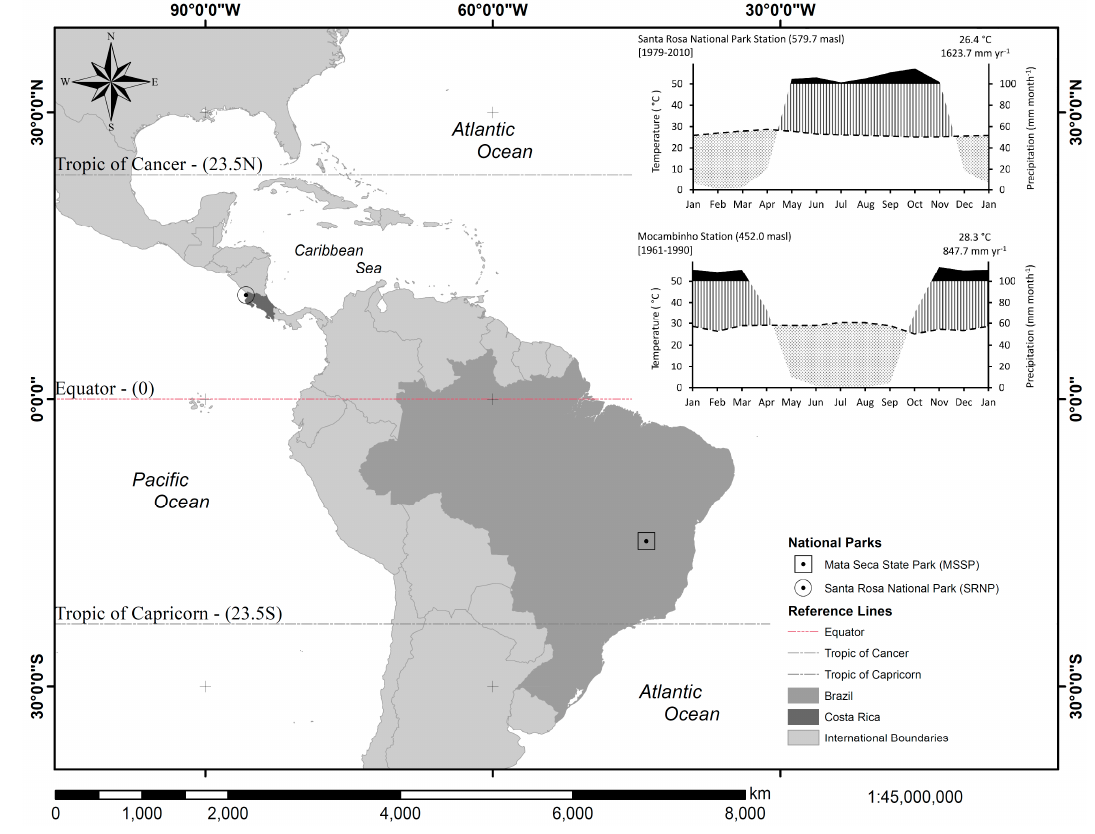
Figure 1. Geographical location of the study sites and the climate diagram of the nearest meteorological station in Costa Rica and Brazil. The solid black area, the vertical line, and the dotted areas in the climate diagrams represent the wettest months, water excess, and water deficits, respectively; the dotted line represents the mean monthly temperature.